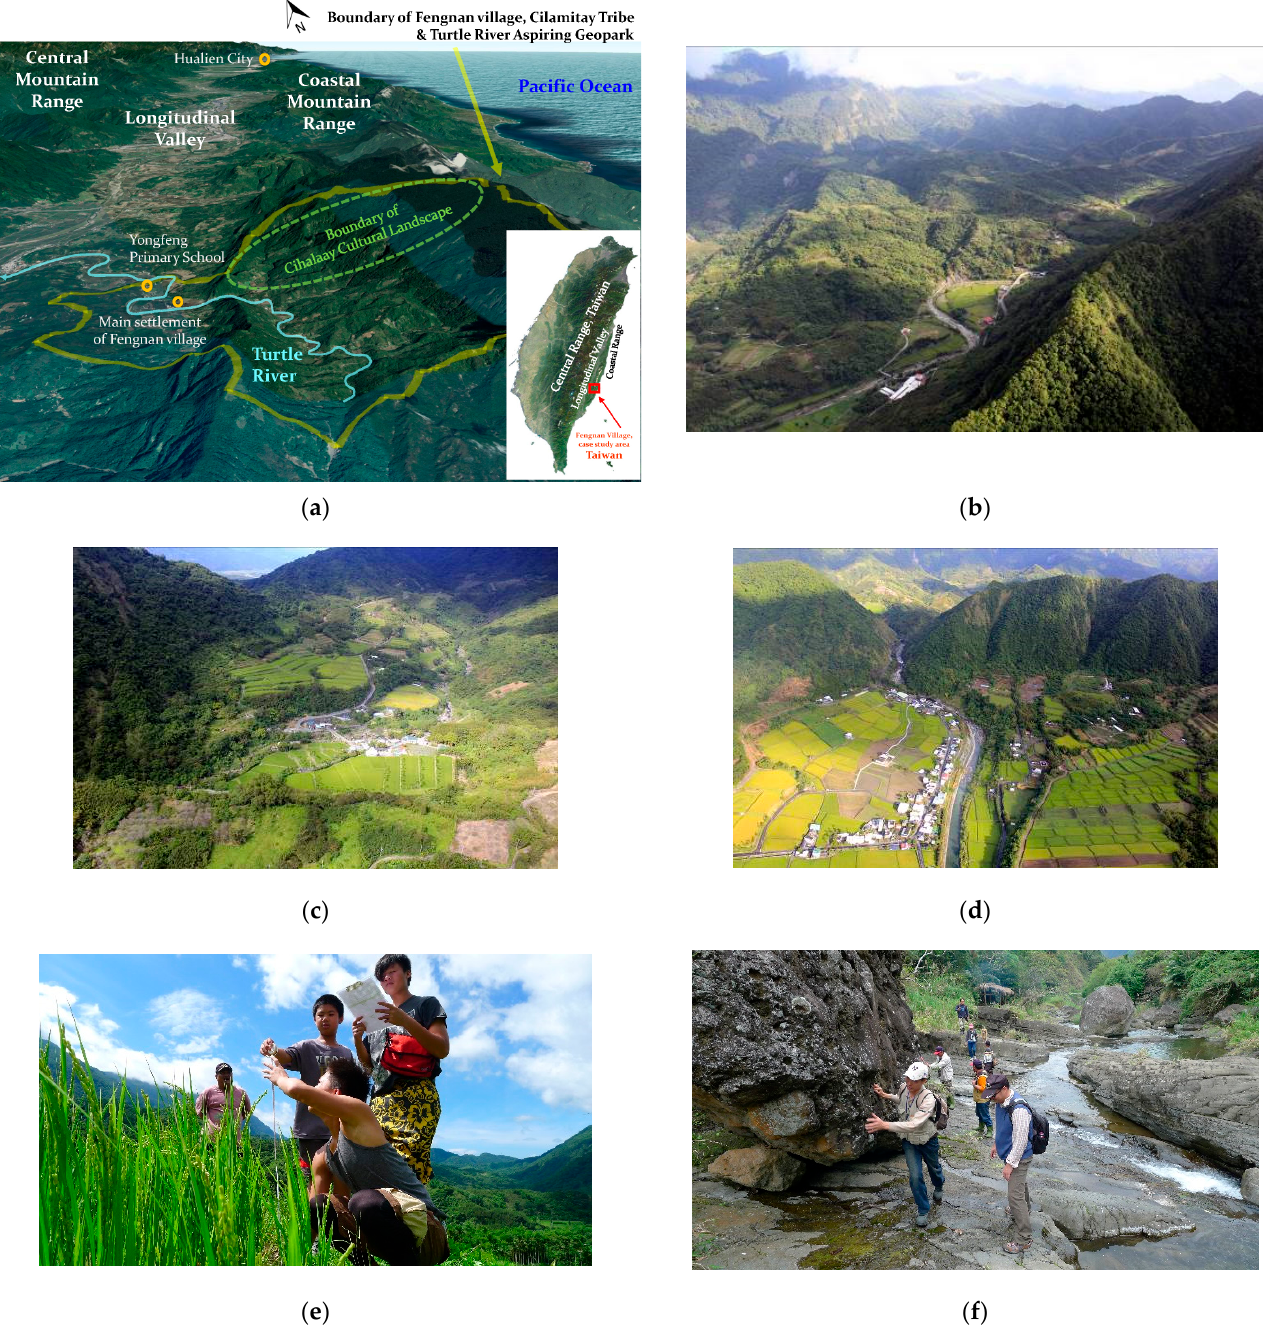
Figure 1. Fengnan Village as a coupled socio–cultural–biophysical system: ( a ) location of case study area; ( b ) upstream area of the Turtle River valley; ( c ) Cihalaay Cultural Landscape; ( d ) Small Tianxiang Gorge and the main settlement of Cilamitay Tribe along the middle reaches of the Turtle River terraces, meanders, and alluvial plains (source of b, c, d photos: Hualien Branch, Soil and Water Conservation Bureau, Council of Agriculture); ( e ) weekend community-based environmental education courses for Cilamitay Indigenous youth; ( f ) community-based landscape tourism activities.